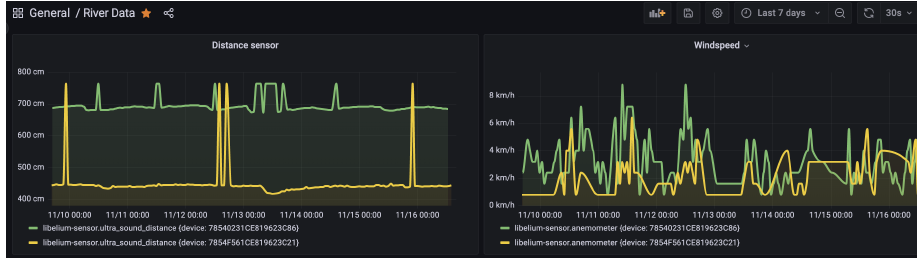
Figure 13. The dashboard on the virtual